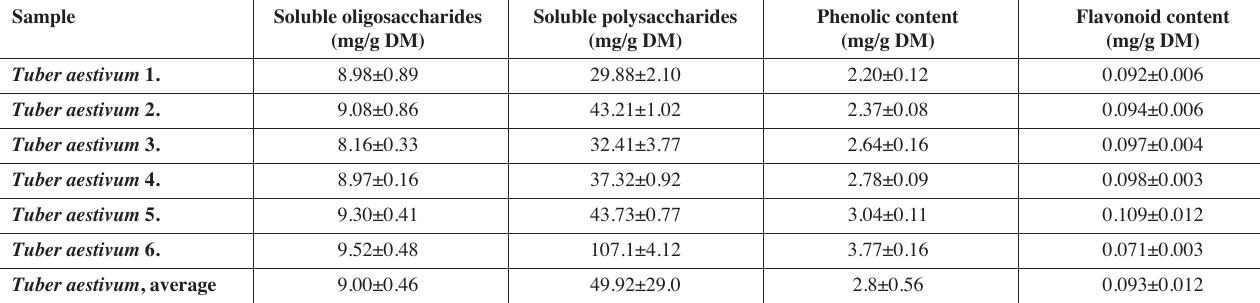
Tab. 3: Soluble oligo- and polysaccharides, total phenoloid and flavonoid contents of Tuber aestivum (mg/g DM, mean ±SD)